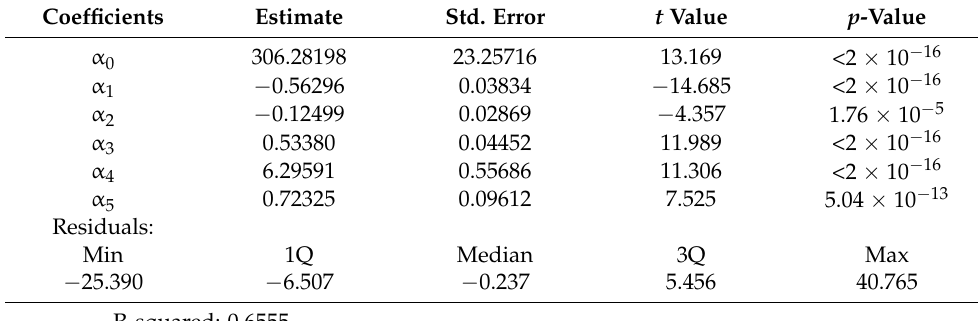
Table A2. The table contains the summary of the model described in Equation (4) adjusted to the training